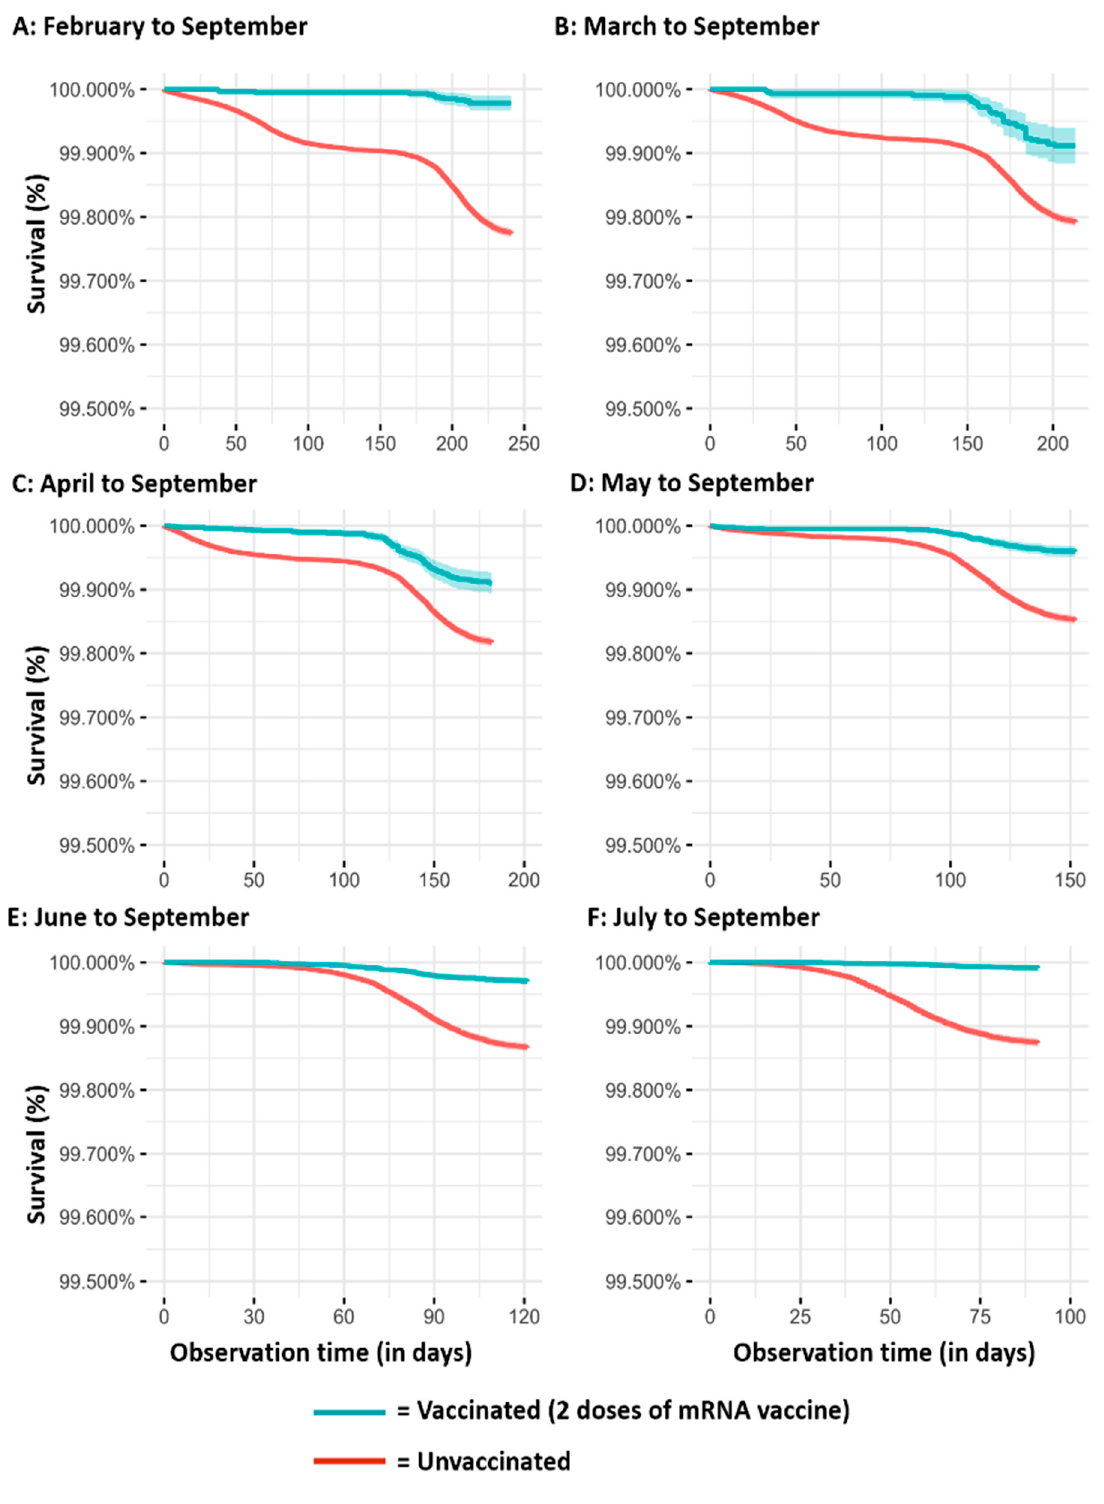
Figure 2. Kaplan–Meier survival analyses on COVID-19 severe cases over time in vaccinated and unvaccinated subjects according to the different observation periods (( A ): February to September; ( B ) March to September; ( C ) April to September; ( D ) Mayto September; ( E ) June to September; ( F ): July to September).